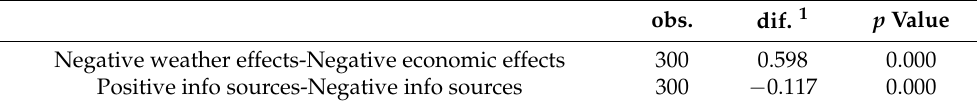
Table 3. Comparison of two